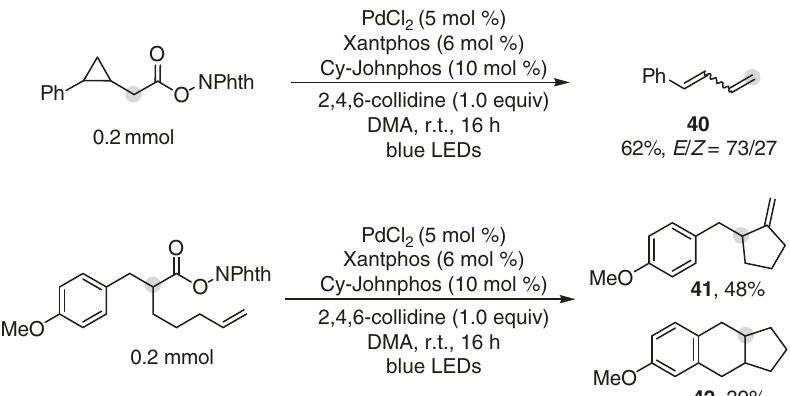
Fig. 7 Radical-clock experiments. Ring-opening/ring-closure experiments supporting the radical property of alkyl-palladium species under irradiation